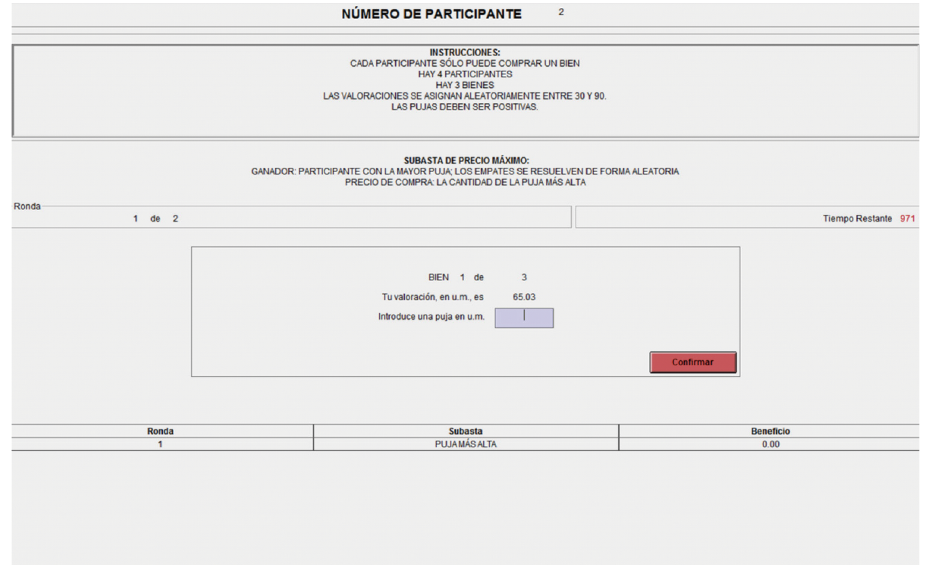
Figure A1.1. Placing a